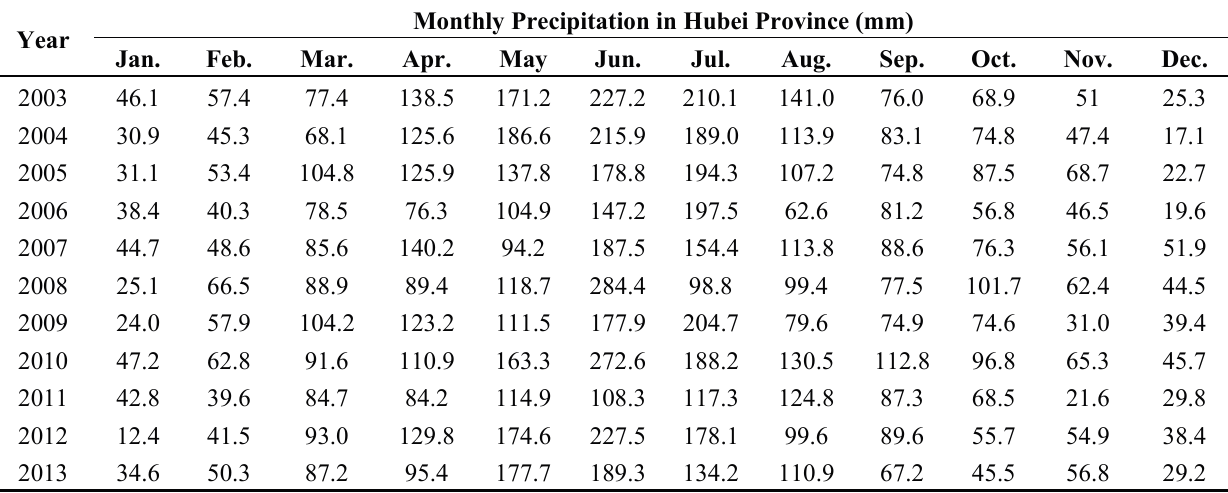
Table 2. Monthly precipitation in Hubei province from 2003 to